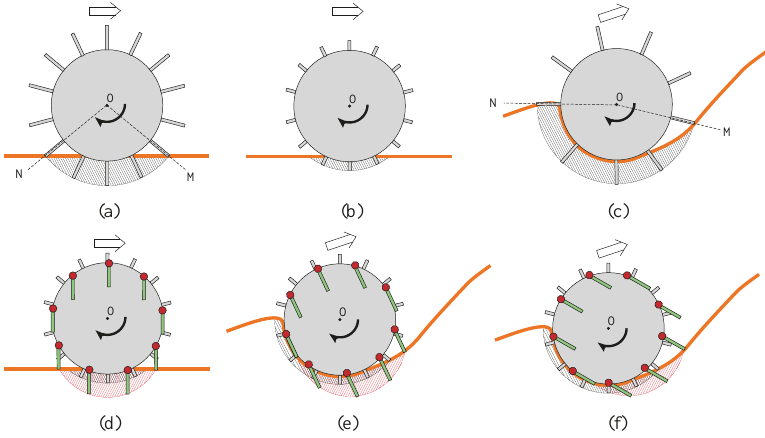
Figure 10. Contact area of the grousers with the sand underneath the surface marked using the shaded area: ( a – c ) Conventional wheels; ( d – f ) Wheels with assistive grousers.